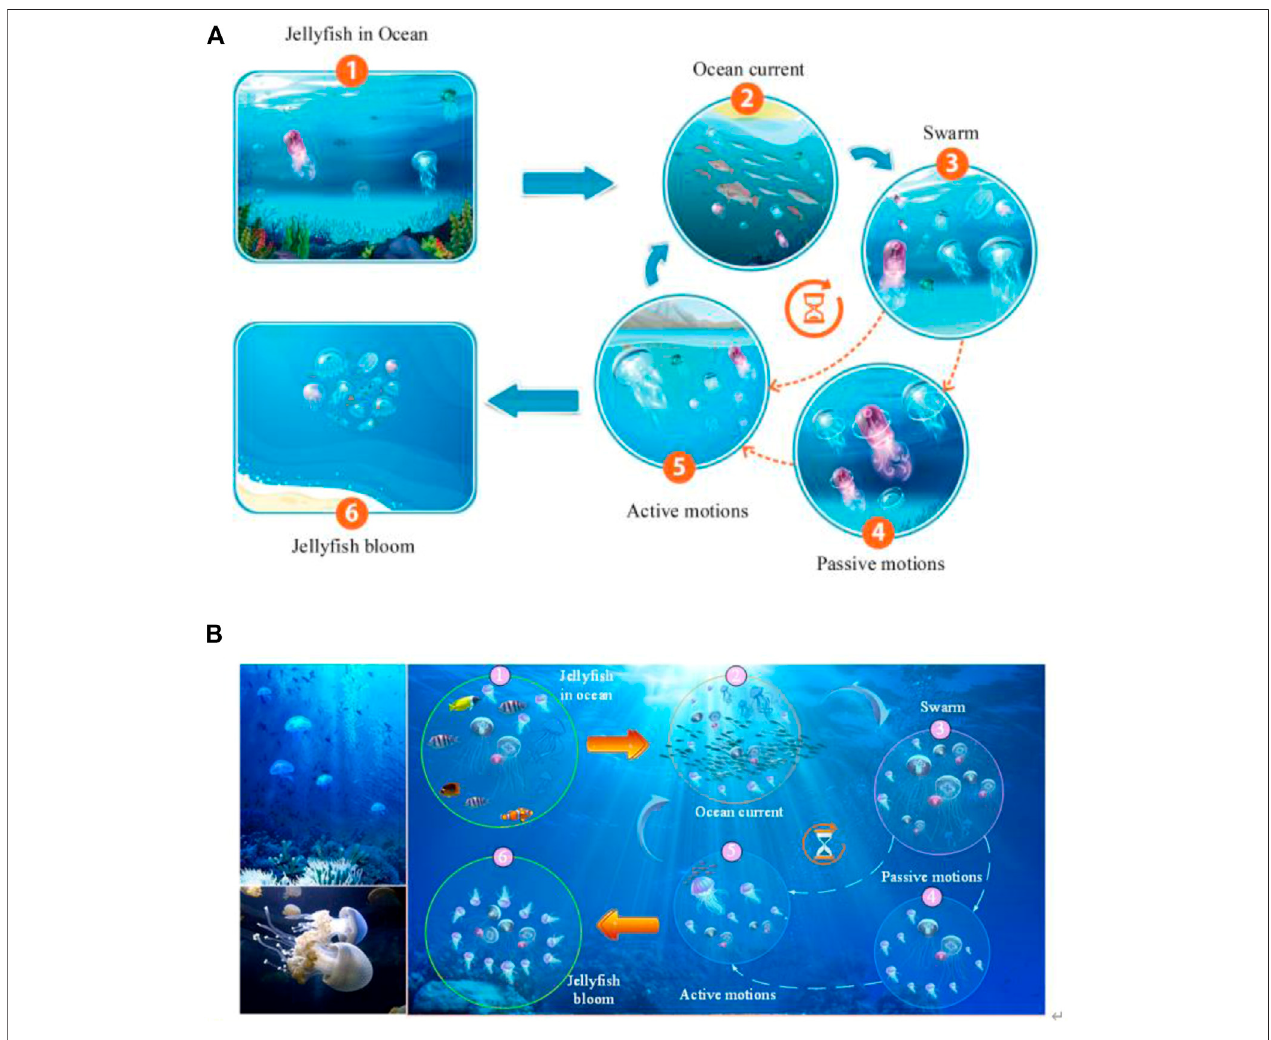
FIGURE 3 | Jelly fi sh ’ s behavior in the ocean. (A) the original fi gure source and (B) redecorated fi gure with citation.